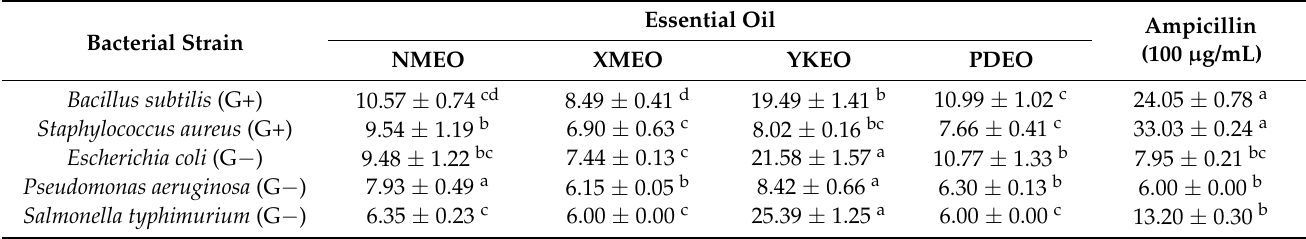
Table 2. Inhibition zone diameters (IZD, mm) of citrus EOs and ampicillin.